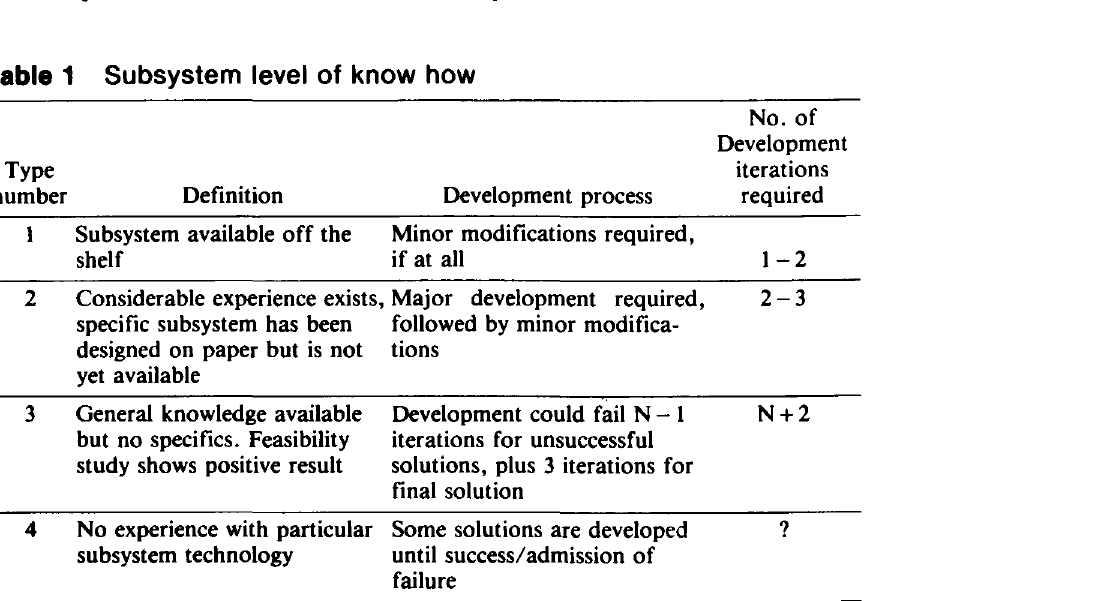
Subsystem level of know